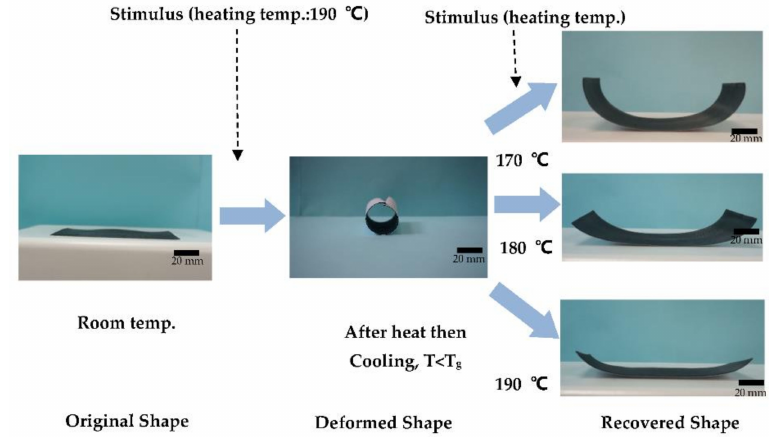
Figure 9. Recovery situations of the stimulus-responsive composite material with heating temperature (190 ◦ C) for the deformation experiment and various heating temperatures for the recovery experiment.